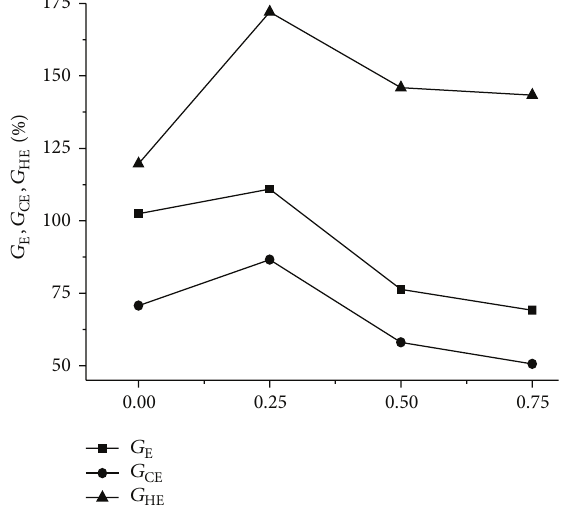
Figure 1: The effect of amount of NaOH upon the hydrogen yield and potential hydrogen yield (water :CMC: feedstock : Raney-Ni = 10g:0.3 g:1g:1g, temperature: 400 ∘ C, and residence time: 20 min).